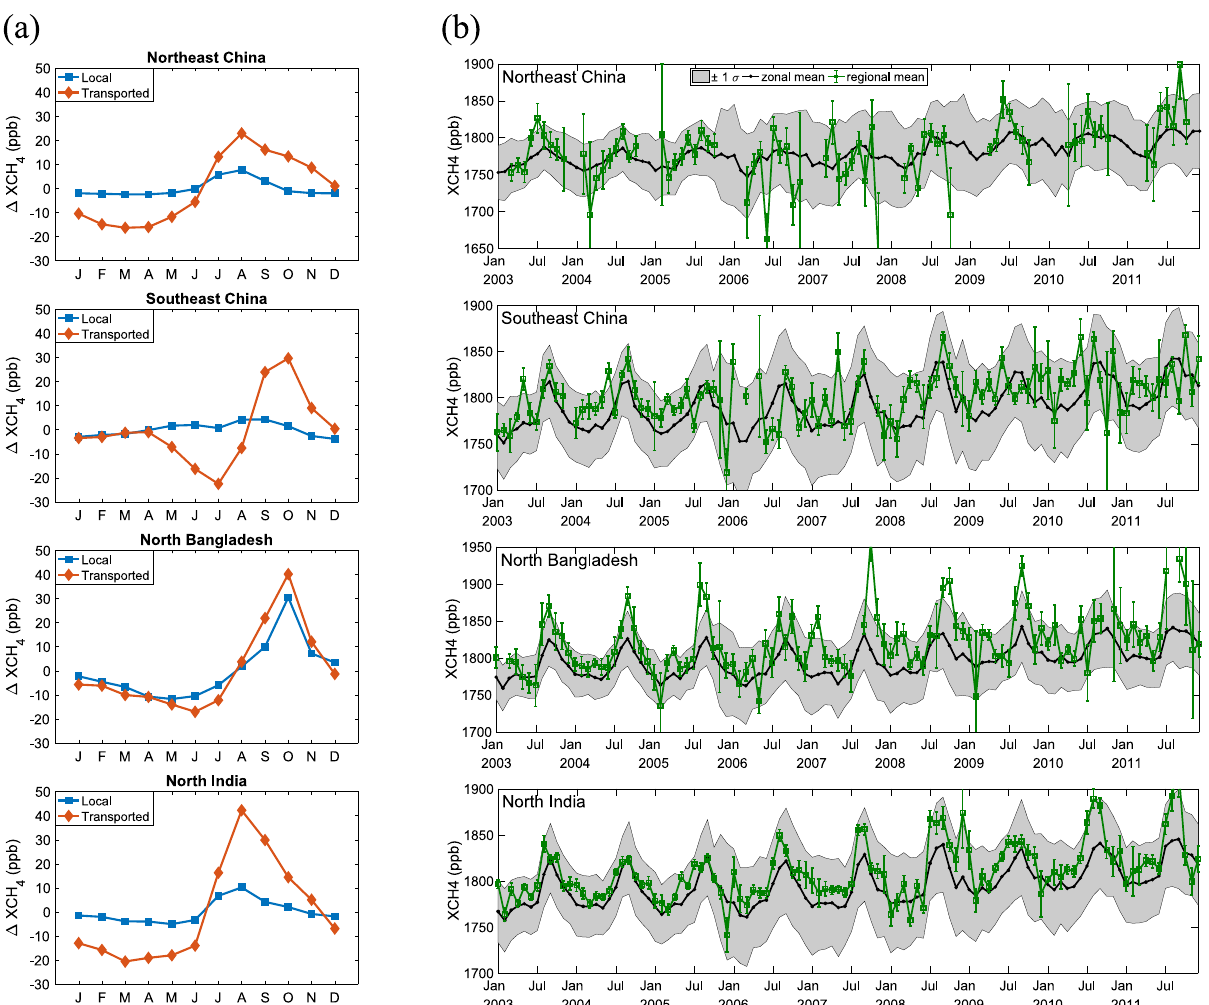
Fig. 1 Measured and modeled monthly XCH 4 for four regions. a The relative contributions of local CH 4 emissions (local) and external CH 4 emissions (transported) to the seasonal cycle of XCH 4 in the four regions of interest (ROIs). These contributions are estimated using the Greenhouse Gas Framework – Flux (GHGF – Flux; see “ Methods ” ) CH 4 model. The description of the model and related analysis is presented in “ Methods ” . b The monthly averaged XCH 4 in four ROIs: Northeast China, Southeast China, North Bangladesh, and North India, the same with the ROIs in Fig. 3a – d of Zhang et al. 1 . The error bars are the monthly uncertainties calculated by error propagation from the uncertainties in XCH 4 retrievals in a certain month; zonal means which are the averaged XCH 4 over the latitudinal band centered in the ROIs and the uncertainty estimate by one standard deviation in the shaded background are overlaid. The zonal latitudinal bands are 40° – 50°N, 23° – 33°N, 20° – 30°N, and 20° – 30°N, respectively, for the four ROIs. The correlation coef fi cients between the zonal means and regional means are 0.53, 0.50, 0.73, and 0.83, respectively, with all p values less than 0.01 from the signi fi cance tests of the linear regression